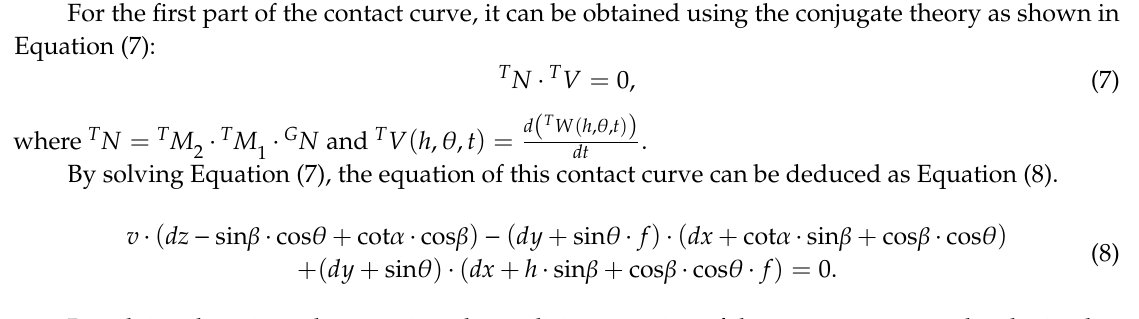
Figure 3. Illustration of the flute generation and the contact curve.